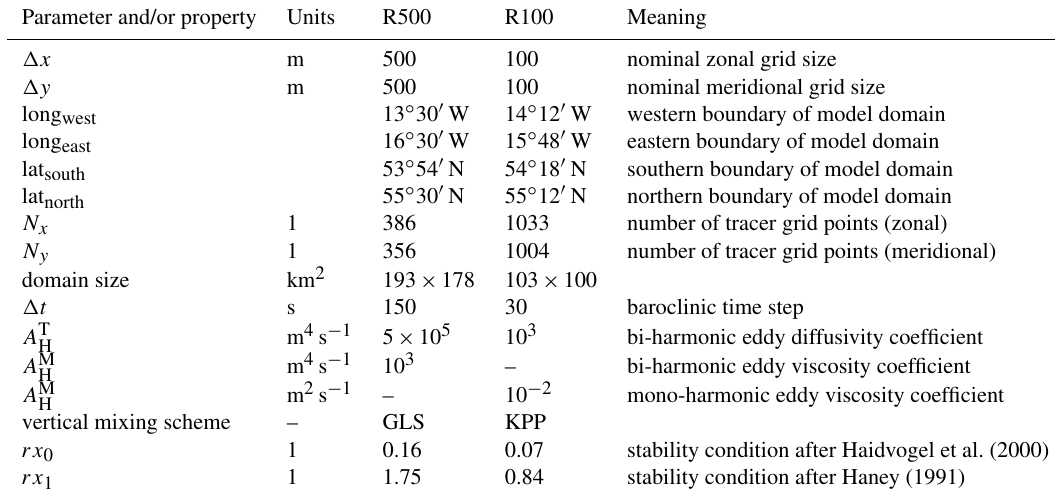
Table 2. Parameter settings and properties of the R500 and R100 setups. Parameter and/or